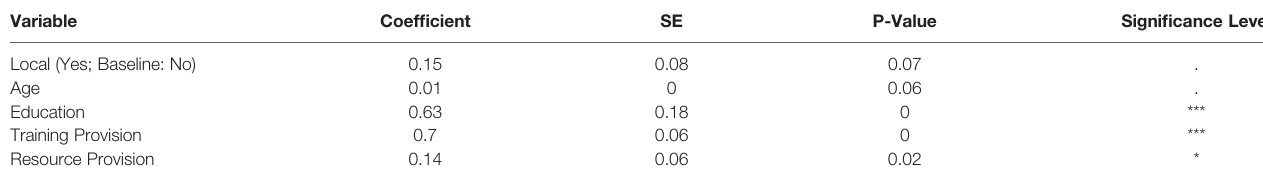
TABLE 4 | Coef fi cients, standard errors (SE) and p-values for the fi nal ordinal model with the dependent variable of perceived respect from local communities.